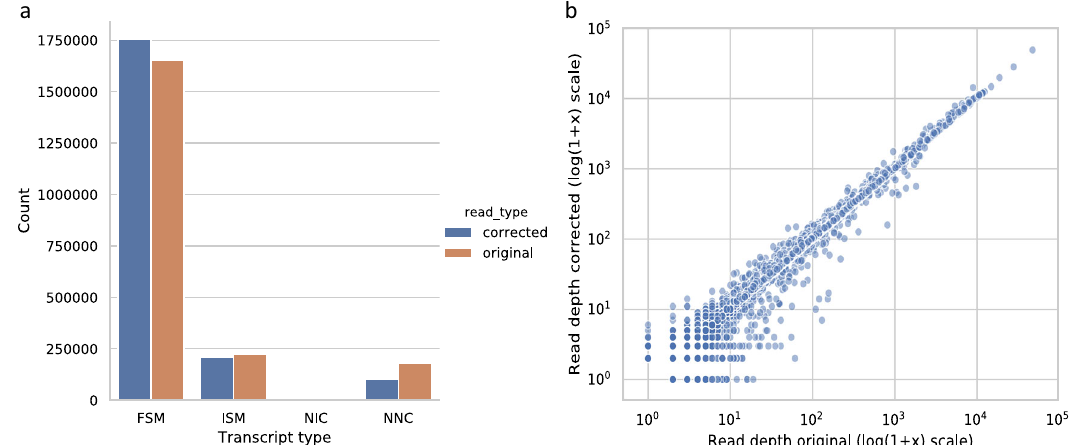
Fig. 3 Splice site accuracy before and after error correction in the Drosophila data. a Total number of reads classi fi ed per splice site category, using the terminology of ref. 28 . FSM full splice match, ISM incomplete splice match, NIC novel-in-catalog, NNC novel-not-in-catalog. b For each transcript in the reference, we measure the number of reads aligning to it as an FSM, before and after error correction. Each dot represents a distinct transcript with at least one FSM in either the original or corrected